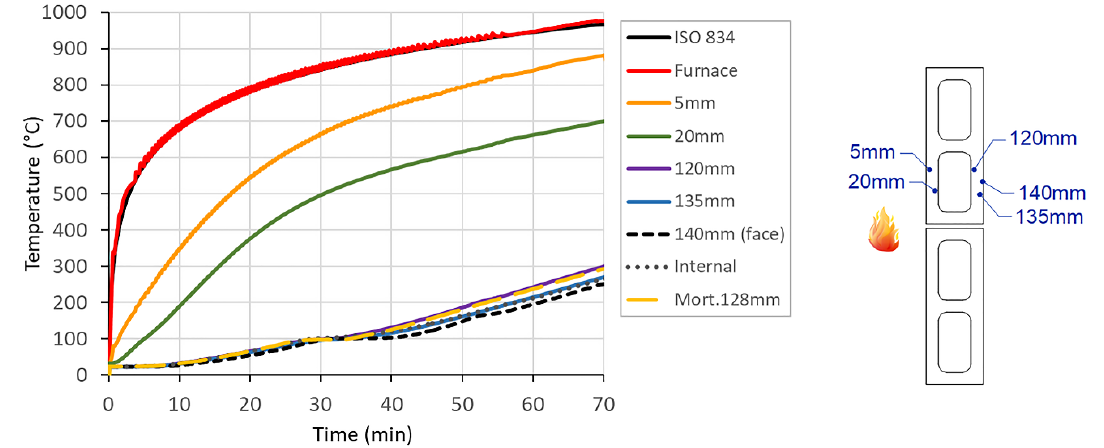
Figure 8. Small walls with fire acting on only one of its